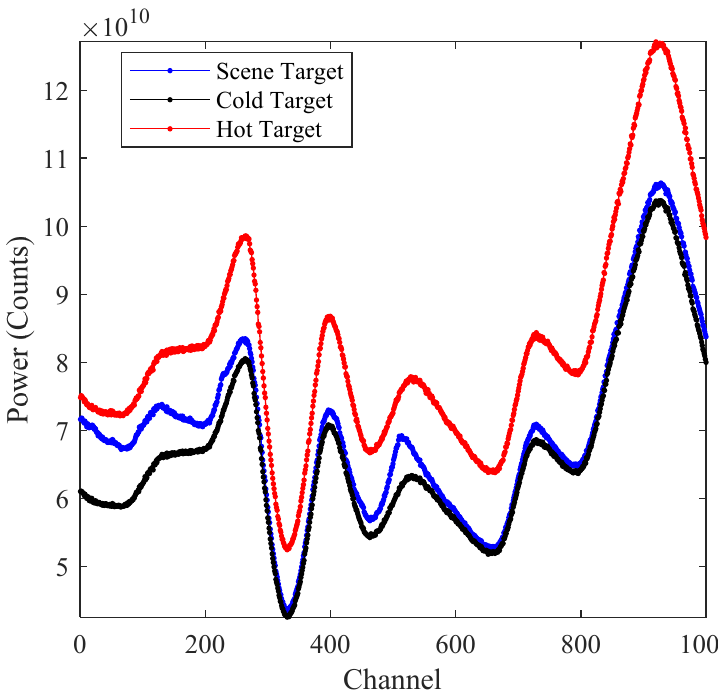
Figure 7. The power spectrum after the integration time of 5 ms.